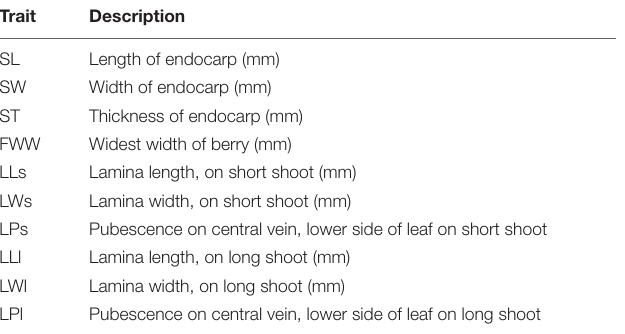
TABLE 3 | Description of bud burst, flower opening, and leaf shedding score